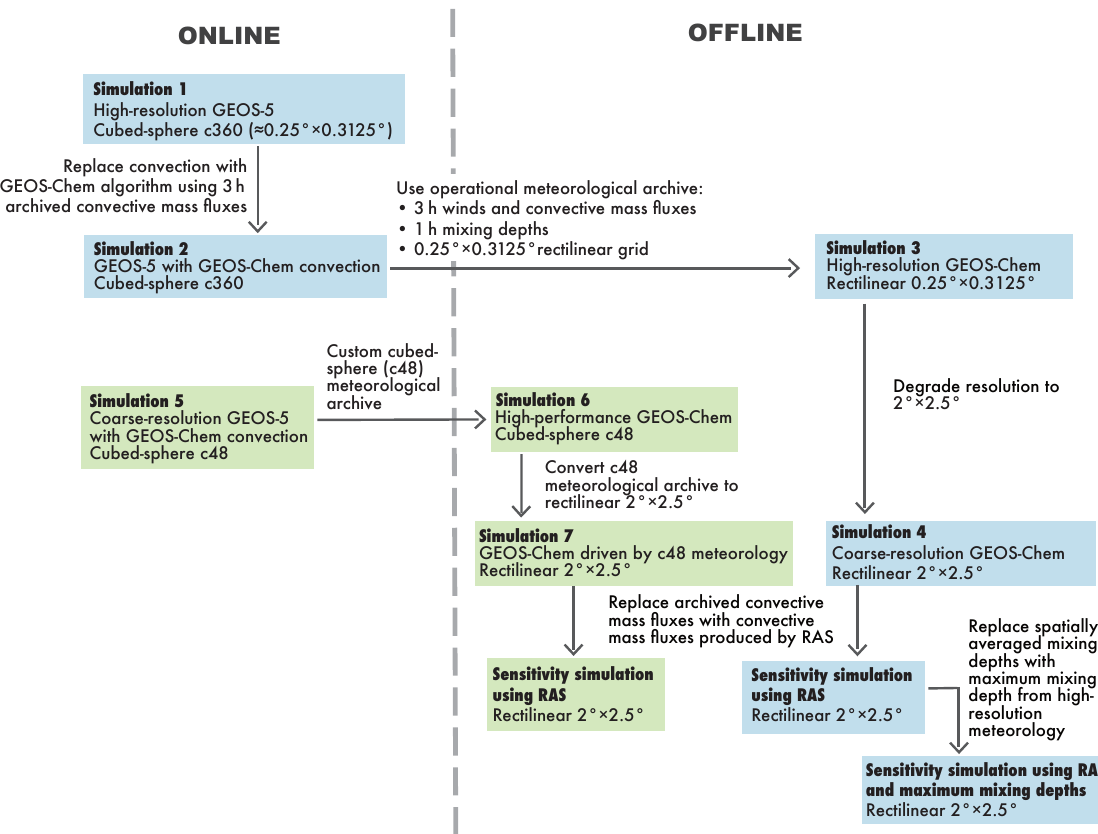
Figure 1. Ensemble of global 222 Rn– 210 Pb– 7 Be simulations conducted in this work. The blue and green boxes identify simulations origi- nating from reference high-resolution (c360) and coarse-resolution (c48) GEOS-5 meteorological products, respectively.